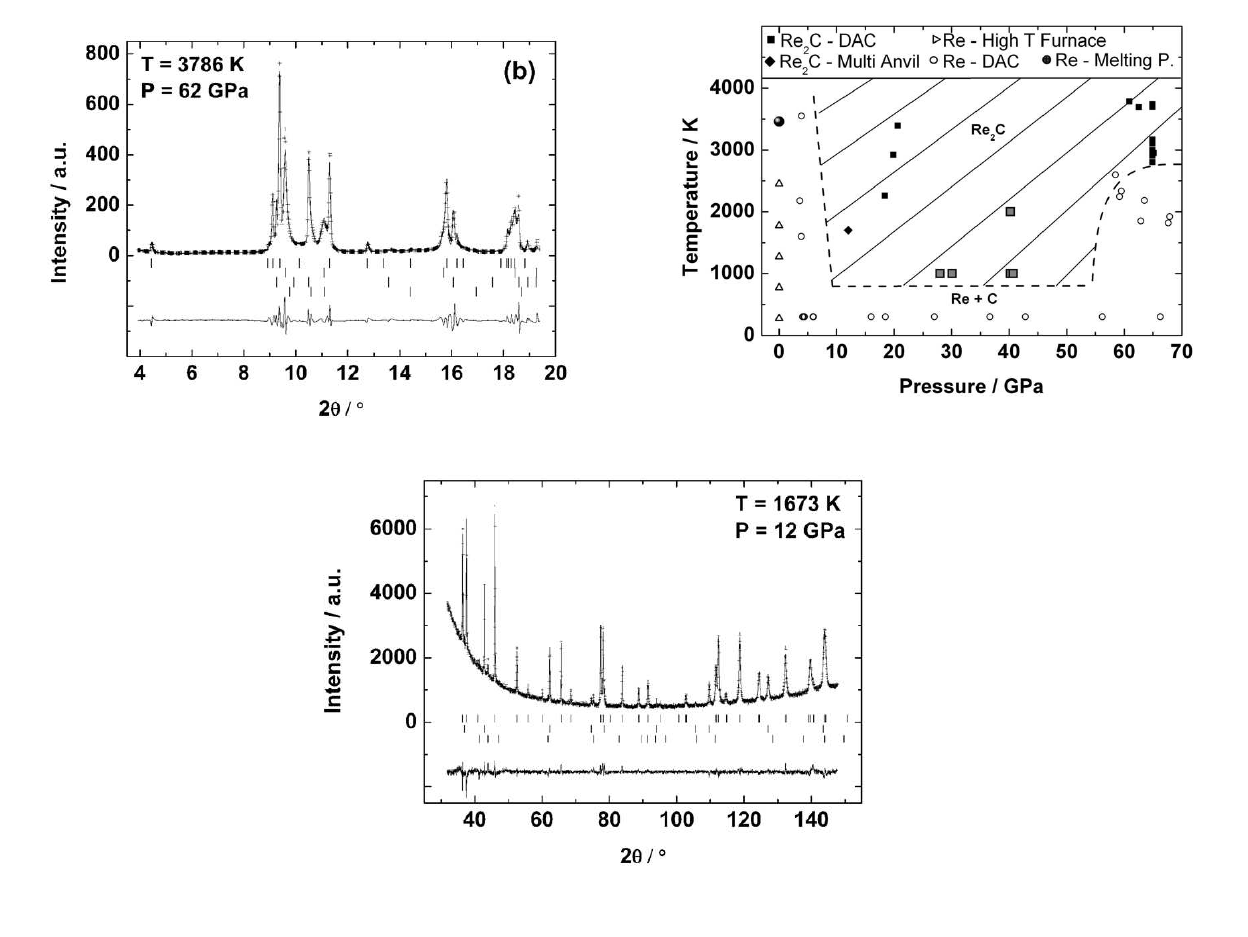
Figure 14. Top left: Powder X-ray diffraction pattern of the reacted Re at high ( p, T ) ( λ = 0.3738 ˚A). Top right: ( P, T )-field in which Re Bottom: Powder X-ray diffraction pattern and Rietveld refinement of a sample synthesized in a multi anvil press ( λ = 1.5406